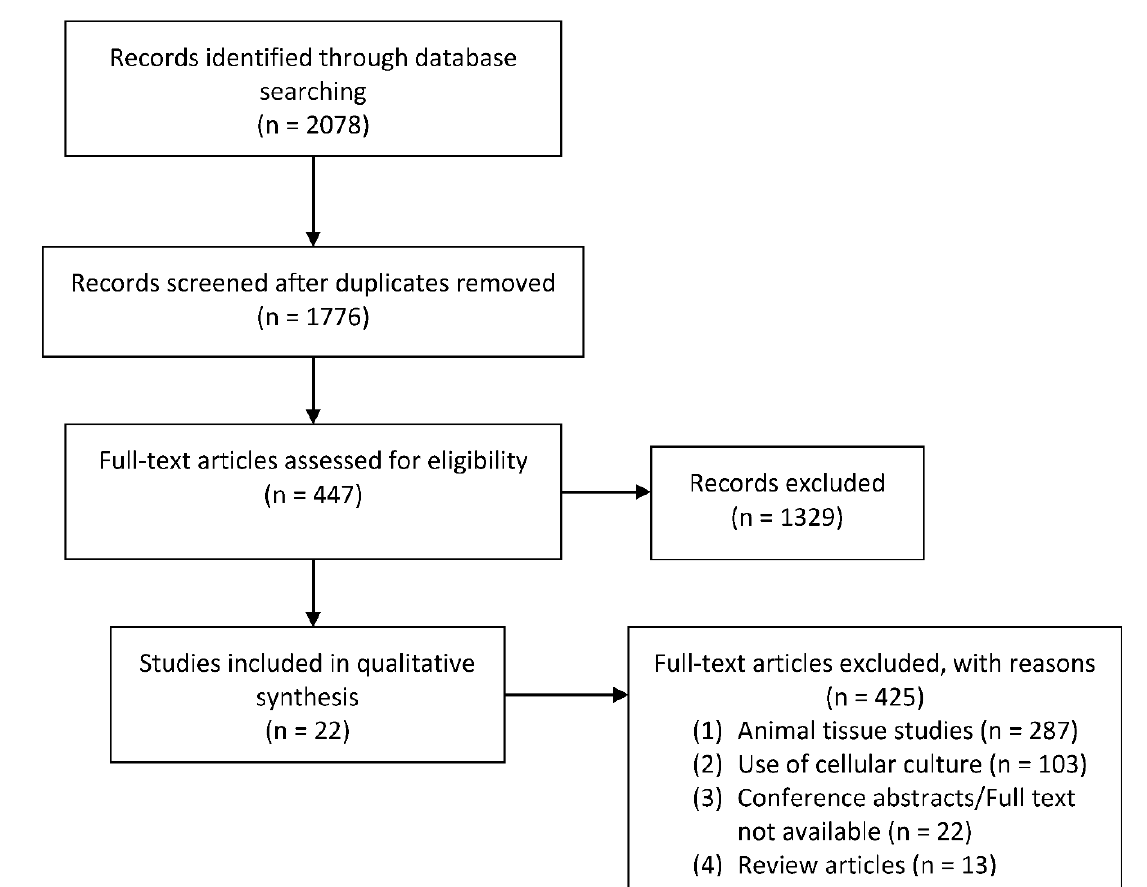
Figure 1. PRISMA flow diagram of search strategy and included articles.